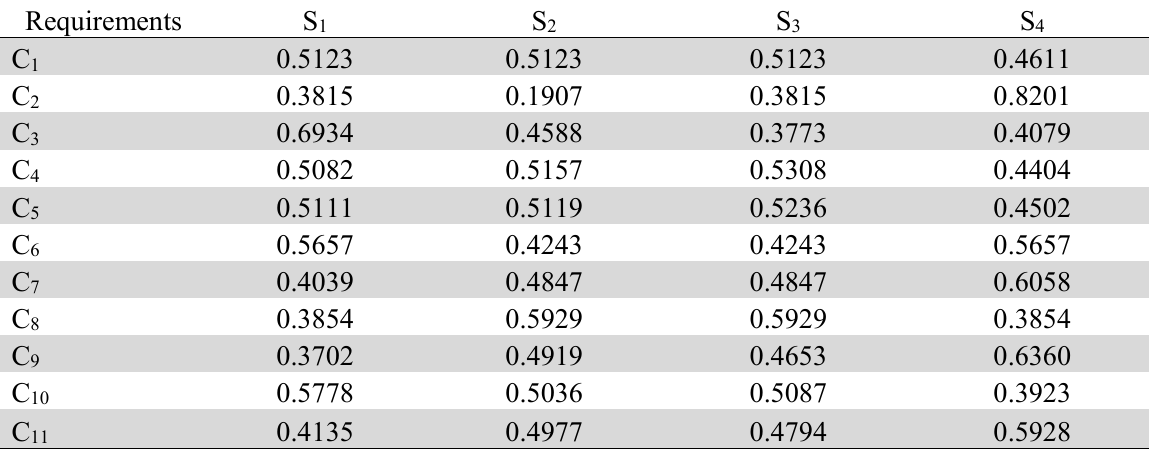
Normalised values of the EST Requirements